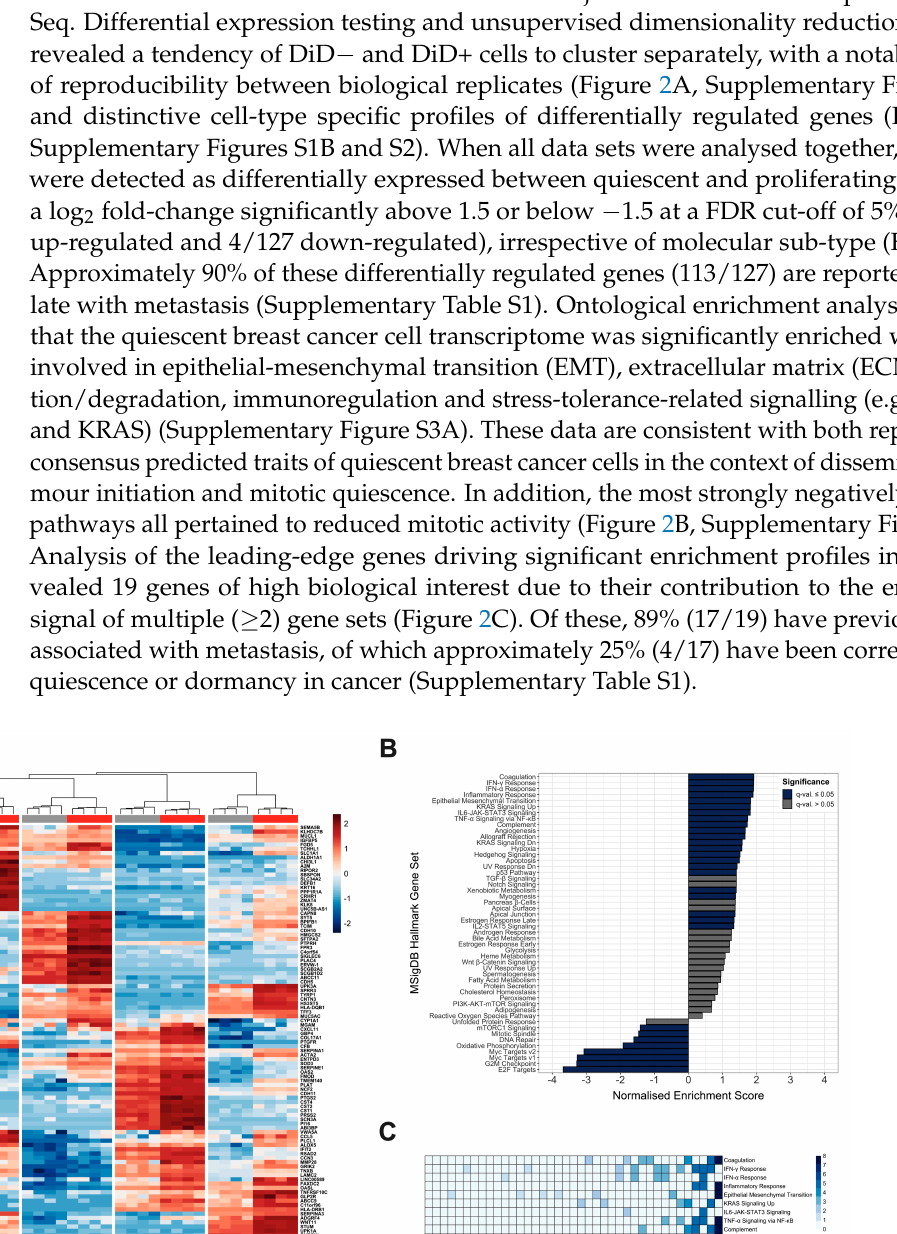
Figure 2. Ontological and Functional Analysis of the Quiescent Breast Cancer Cell Transcriptome. ( A ) Agglomerative hierarchically clustered heatmap of mean-centered, TMM normalised log 2 -transformed CPM gene expression values as quantified by mRNA-Seq. Clustering is unsupervised and based on Euclidean distances calculated from an average-linkage matrix. All genes detected as differentially expressed with a log 2 fold-change significantly above 1.5 (up-regulated) or below − 1.5 (down-regulated) at an FDR-adjusted p -value ( q- value) ≤ 5% across all breast cancer cell lines are shown (127 total). Grey and red bars represent Vybrant ® DiD − negative (DiD − ) and Vybrant ® DiD − positive (DiD+) grouping, respectively. ( B ) Gene set enrichment analysis of the differentially expressed genes using MSigDB hallmark collection gene ontologies denoted by enrichment score normalised to mean enrichment of randomised equivalent samples (hypergeometric test with post-hoc Benjamini-Hochberg FDR adjustment). ( C ) Analysis of leading edge genes identified as driving significant enrichment of MSigDB hallmark collection gene sets. Columns indicate quiescence-associated signature genes contributing to the enrichment signal of the gene set(s) indicated by row labels. Colour is scaled to the number of leading edge gene sets in which each gene appears. For clarity, only signature genes that appear in ≥ 1 ontologies are shown. ( D ) Composite functional association network constructed for genes detected as differentially regulated with a log 2 fold-change significantly above 1.5 (up-regulated) or below − 1.5